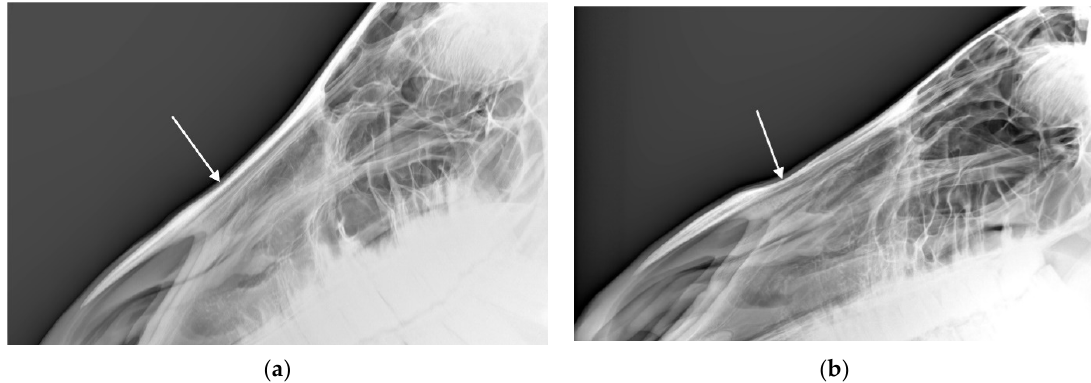
Figure 5. Radiographs showing the nasal bones of a horse in which radiologists ( n = 2) agreed there was bone thinning that was: ( a ) typical of affected horses and ( b ) moderate.